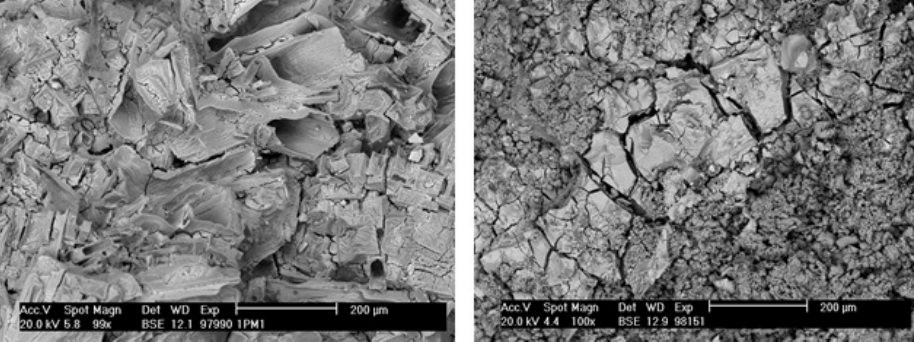
Figure 5 : The bronze sample from Process 1 imaged at 20 keV by the BSE detector before the plasma chemical reduction process (left) and after it (right).